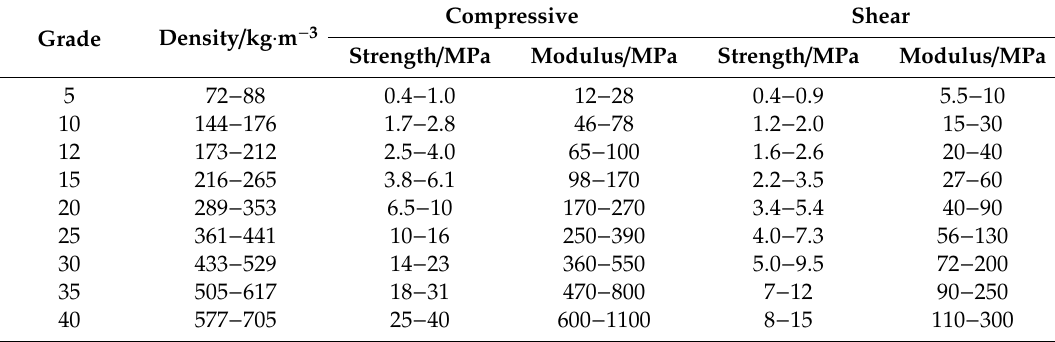
Table 4. Mechanical properties (minimum and maximum requirements) of bone models used for testing orthopedic